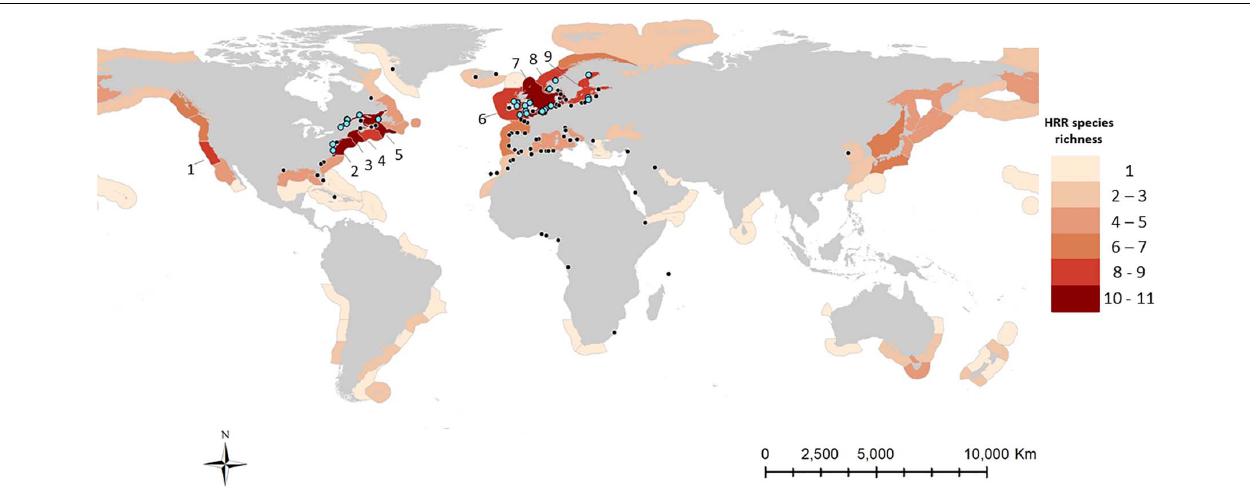
FIGURE 5 | Map illustrating source ecoregions of highest risk species for the Hudson Bay Complex. HRR species richness (number of HRR species present in their native and invaded ranges. Species included: C. opilio, P. camtschaticus , A. tonsa , M. arenaria, L. littorea , C. fragile , S. muticum , A. limbata , M. leidyi , C. maenas , M. viridis , M. membranacea , G. tigrinus , and U. pinnatifida ). Ecoregions are as delineated by Spalding et al. (2007) (1: Northern California, 2: Virginian, 3: Gulf of Maine/Bay of Fundy, 4: Scotian Shelf, 5: Gulf of St. Lawrence/Eastern Scotian Shelf, 6: Celtic Seas, 7: North Sea, 8: Southern Norway, 9: Baltic Sea). Black circles represent last port of call and ballast water source ports that were connected to ports in the Hudson Bay Complex (single or multiple discharge events); blue circles represent ports situated in locations with highest AIS richness that registered multiple discharge ballast water events. Port and ballast water discharge information is from Goldsmit et al.